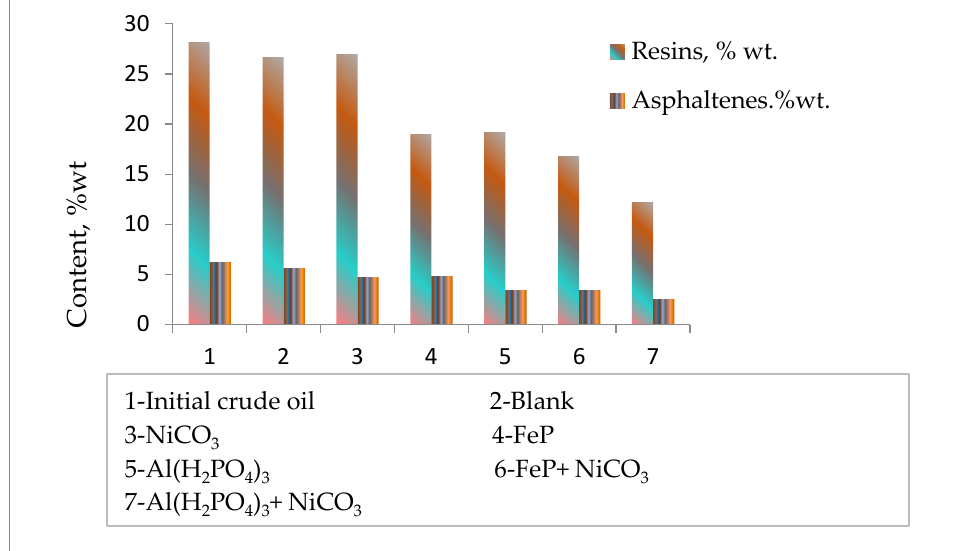
Figure 4. The content of resins and asphaltenes before and after thermolysis.